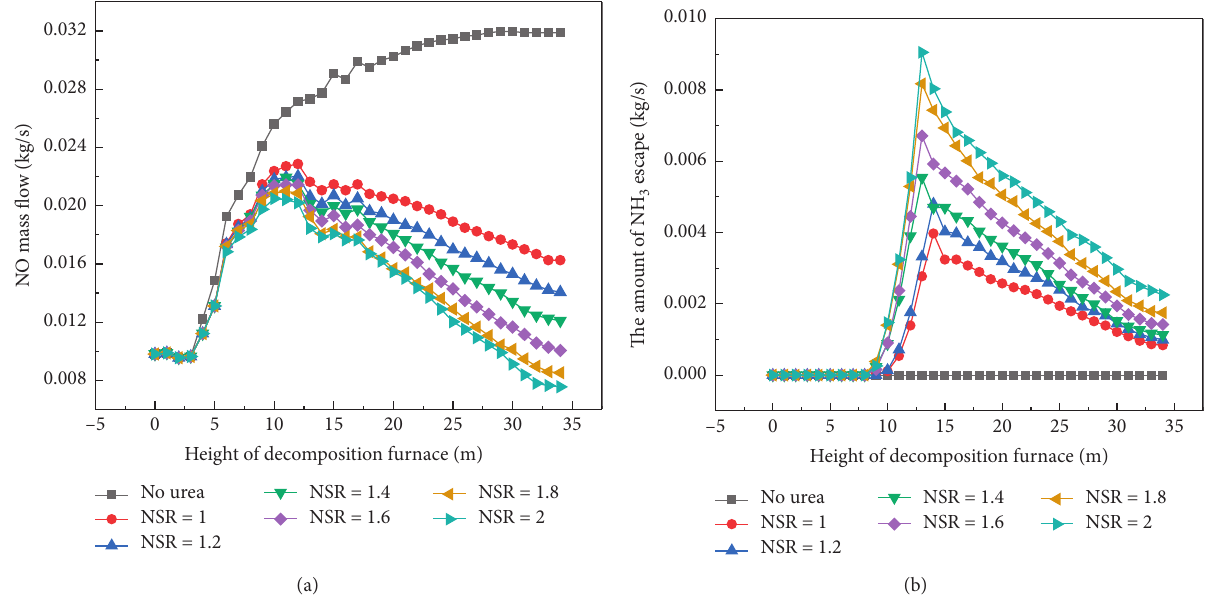
Figure 8: Flow curves of NO (a) and NH 3 (b) in the decomposing furnace with different NSR.